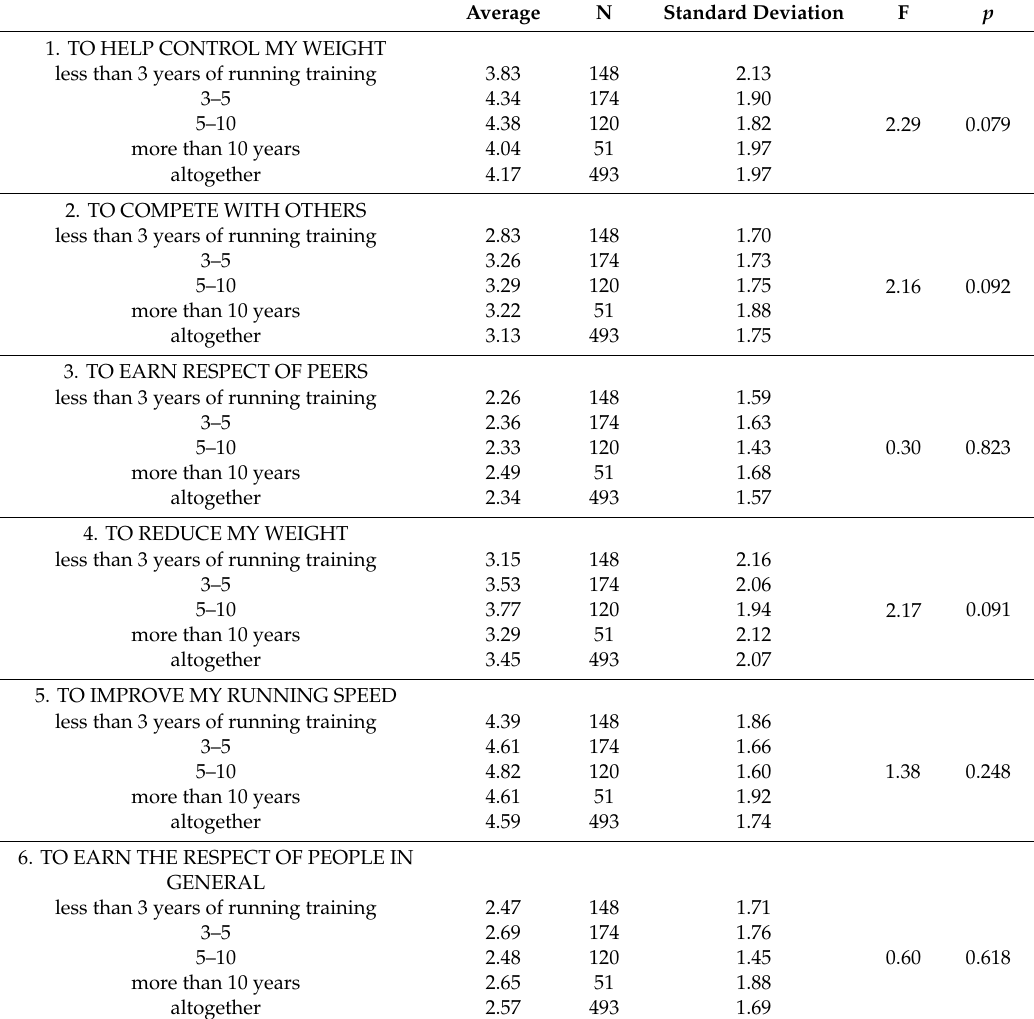
Table A1. The analysis of the significance of di ff erences between the four groups (according to years of running training) in relation to all the 56 MOMS